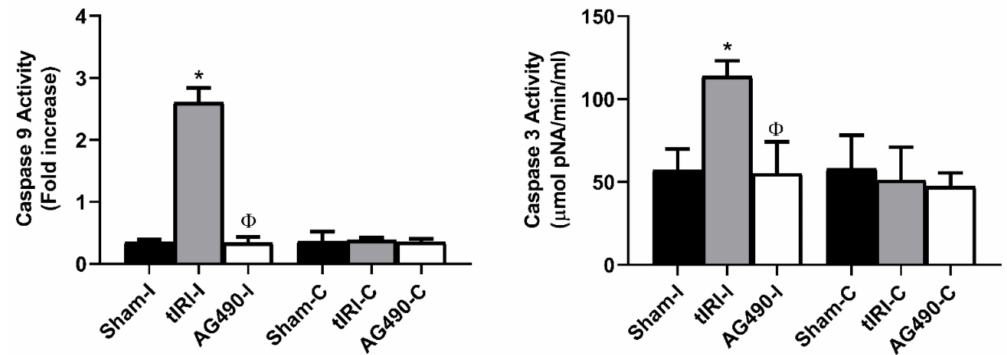
Figure 4. JAK2 activation promotes apoptosis during tIRI. Induction of the caspase cascade in response to JAK2 activation was demonstrated by the increased activities of the initiator caspase 9 and the executioner caspase 3 during tIRI compared to sham (* p < 0.0001). Treatment with AG490 (40 mg/kg) prior to reperfusion suppressed the activation of caspases 9 and 3 ( Φ p < 0.0001). The contralateral testes in all groups showed no significant difference ( p > 0.05). Data are presented as mean ± SD ( n = 6/group). * tIRI compared to sham and Φ AG490 compared to tIRI. I = Ipsilateral and C =